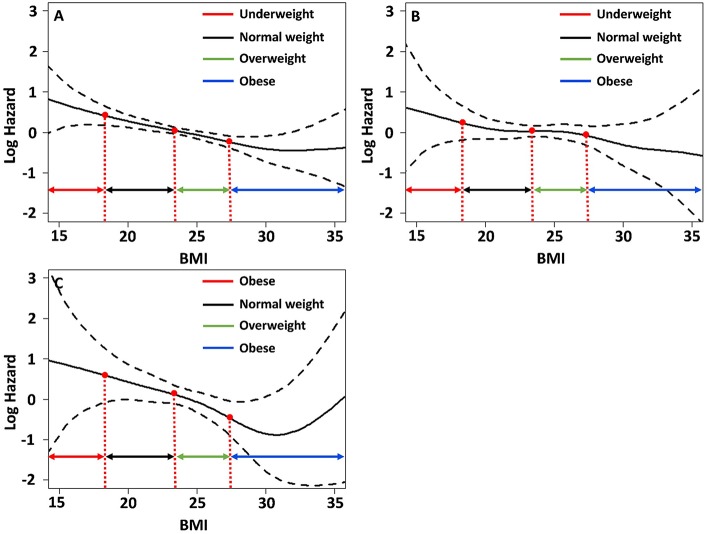
Relative hazards of BMI on (A) major adverse cardiovascular events; (B) any stroke events; (C) any cardiovascular events after adjusting variables p < 0.1 in the univariate Cox regression analysis.